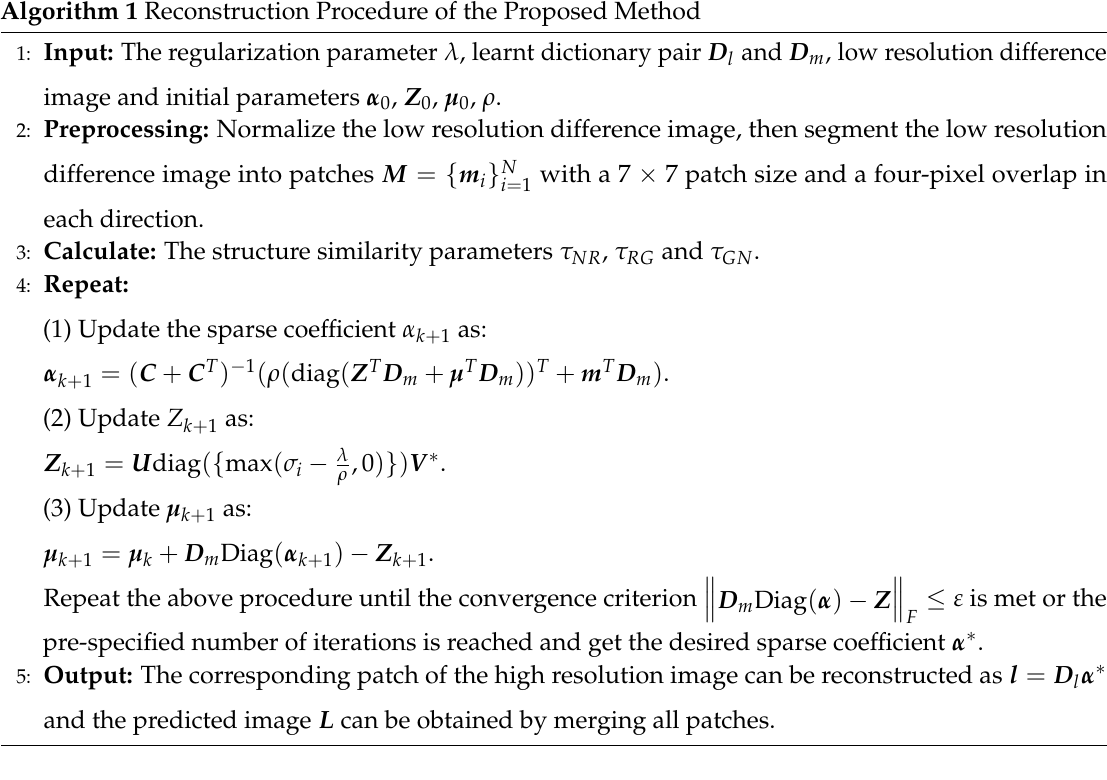
Algorithm 1 Reconstruction Procedure of the Proposed